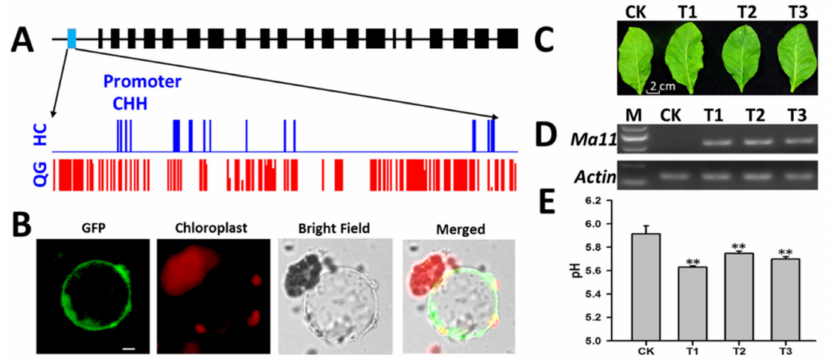
Figure 6. Functional characterization of MdMa11 . ( A ) Differences in the methylation of the MdMa11 promoter in the CHH context between ‘HC’ and ‘QG’ mature fruits. ( B ) Tonoplast localization of the MdMa11-GFP fusion protein in vacuoles, which were obtained after transiently transformed N. benthamiana protoplasts were lysed. Bars represent 10 µ m. ( C ) Transiently transformed tobacco leaves. CK represents tobacco leaves transformed with the empty vector, whereas T1, T2, and T3 represent tobacco leaves transformed with MdMa11 . ( D ) Analysis of MdMa11 expression in tobacco leaves transiently transformed with the empty vector (CK) or MdMa11 (T1, T2, and T3) based on RT-PCR data. ( E ) Analysis of the pH of tobacco leaves transiently transformed with the empty vector (CK) or MdMa11 (T1, T2, and T3). Double asterisks (**) indicate significant differences in the pH of tobacco leaves transiently transformed with the empty vector (CK) or MdMa11 (T1, T2, and T3) ( t -test, p <